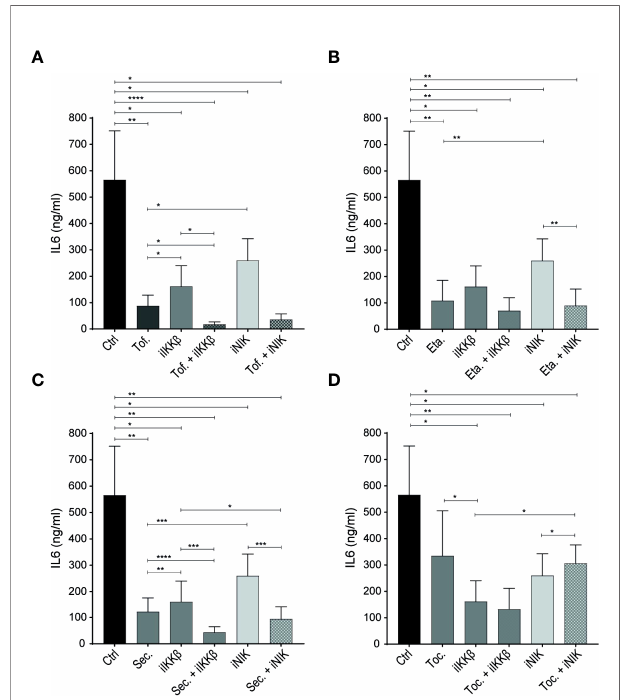
FIGURE 5 | NF- k B inhibitors have additive effects over JAK inhibitors and biological DMARDs. (A – D) IL-6 production by ECs stimulated with 72h T m sup and (A) treated with DMSO (control; ctrl), JAK inhibitor (tofacitinib; Tof.), iIKK b , iNIK or a combination, or treated with (B) TNF blocker (etanercept; Eta.), (C) anti- IL-17 (secukinumab; Sec.) or (D) anti-IL-6R (tocilizumab; Toc.) as single treatment or in combination with iIKK b or iNIK ( n= 5). In (B – D) . *p < 0.05, **p < 0.01, ***p < 0.001, ****p <